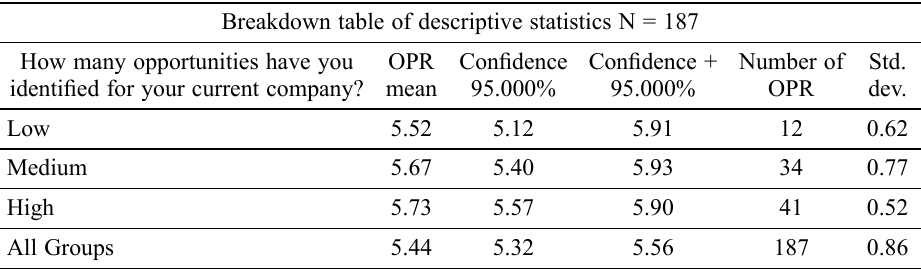
Table 1. Comparison of OPR means by frequency of opportunities recognised Breakdown table of descriptive statistics N =